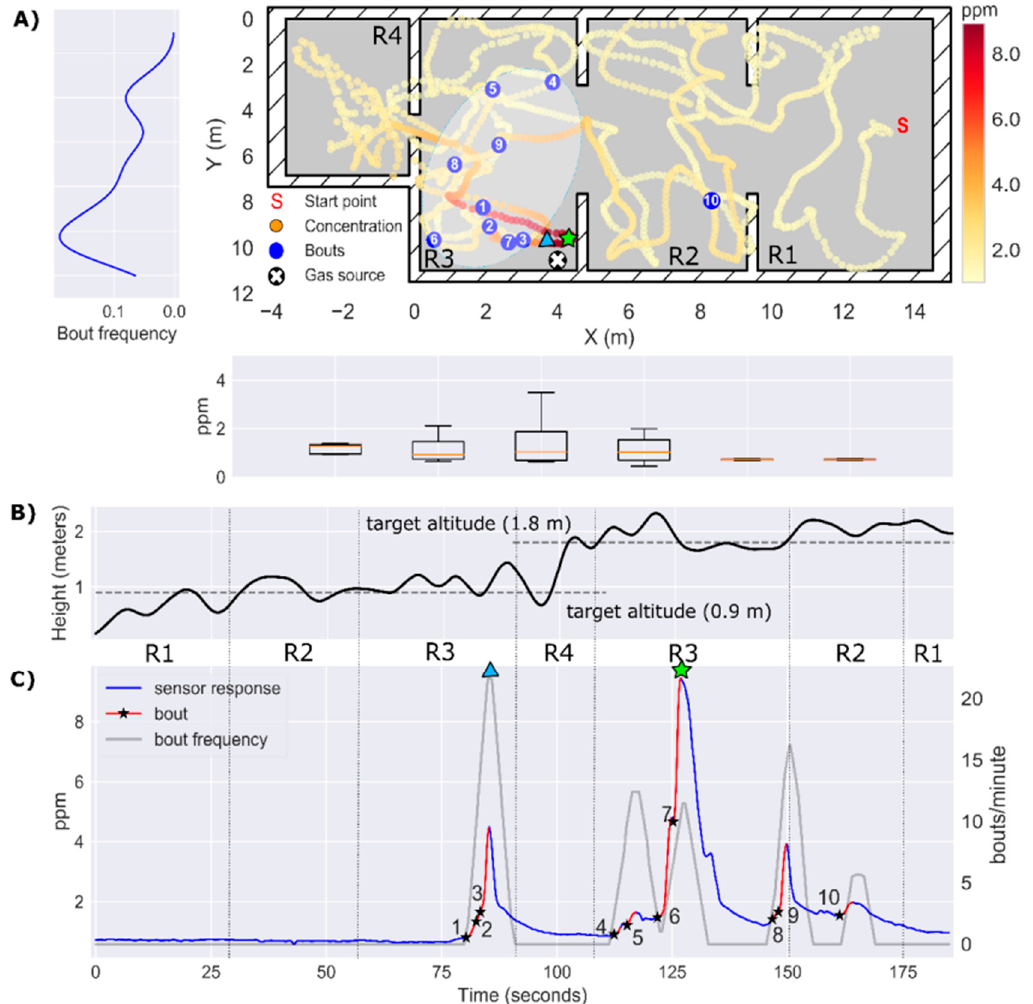
Figure 20. Results of Experiment 3. ( A ) 2D map of the instantaneous concentration (ppm), with bouts represented by blue circles ( b thr = 0.20 ppm/s). A hand-drawn ellipse outlines the approximate plume shape based on the location of bouts. The average bout frequency along the y-axis is shown in the leftmost panel. The box plot below the map represents the instantaneous concentration along the x-axis; ( B ) Drone trajectory in the z-axis. ( C ) Temporal evolution of the instantaneous concentration (ppm), with detected bouts highlighted in red (the black star indicates the start of the bout). The bout frequency (gray line) is computed using a sliding window of 5 s. The identifiers R1–R4 between panels ( B ) and ( C ) indicate the area of the map in which the drone is flying at each moment. The maximum of the instantaneous concentration and the bout frequency are indicated by a green star and a blue triangle, respectively.